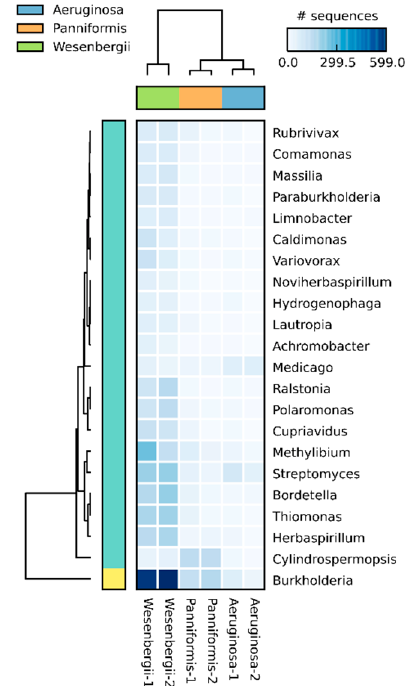
Figure 4. Clustering result of taxonomic analysis results at genus level. Based on the taxonomic analysis results, six samples were clustered at genus level. Metagenomes of the same species showed to be closest with each other. Relatively, the two metagenomes of M. panniformis are closer to M. aeruginosa than that of M. wesenbergii .